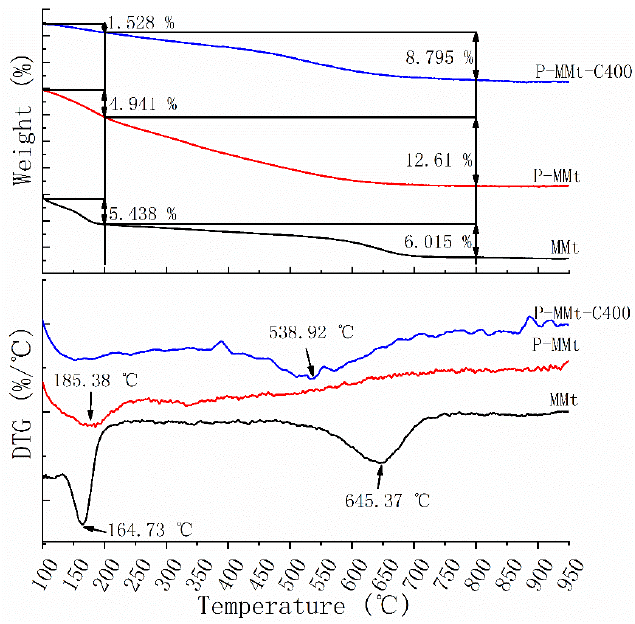
Appl. Sci. 2022 , 12 , x FOR PEER REVIEW Figure 5. The TG and DTG curves of MMt, P-MMt, and P-MMt-C400. Figure 5. The TG and DTG curves of MMt, P-MMt, and P-MMt-C400.